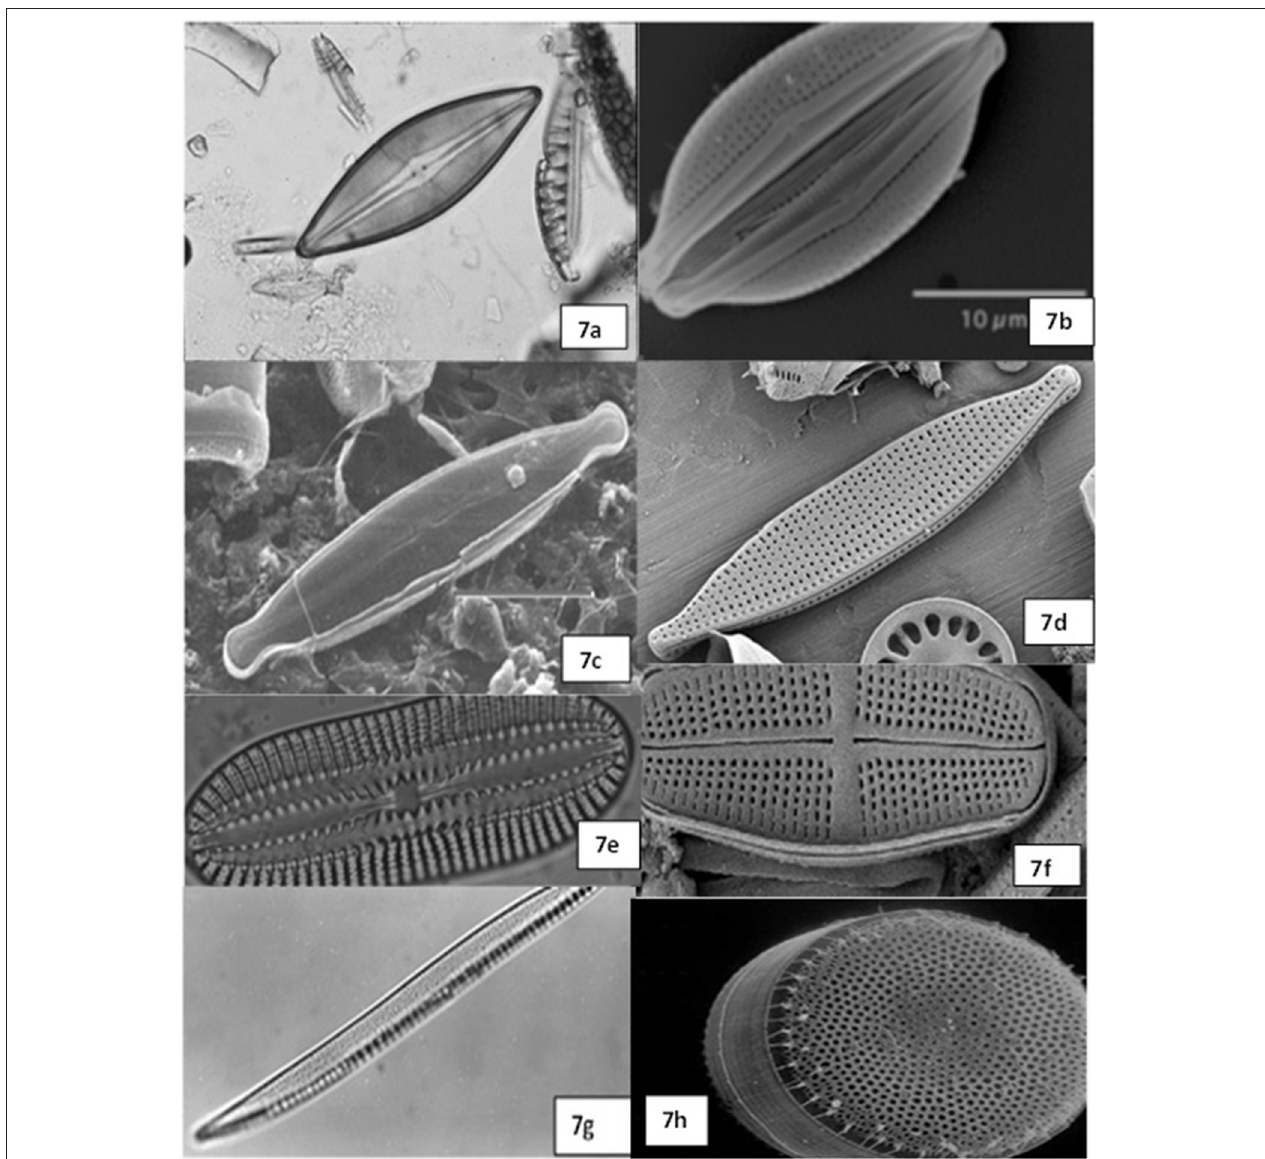
FIGURE 8 | Microscopic images of the diatoms observed in the Blackbird Creek soil samples. 7a–6f, Navicula sp.; 7d, Portion of Cyclotella sp.; 7e,g, Nitzschia sp.; 7h, Thalassiosira